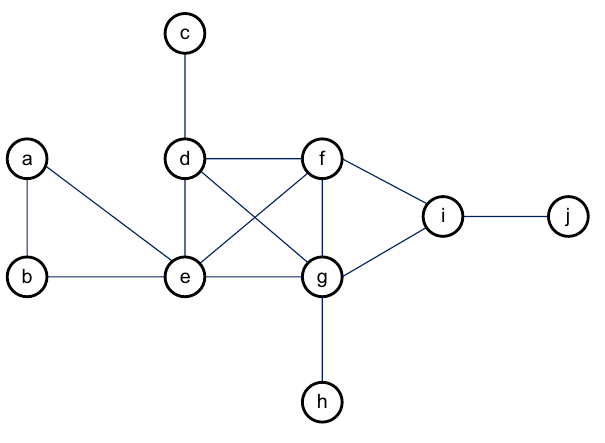
Figure 1. A simple network.